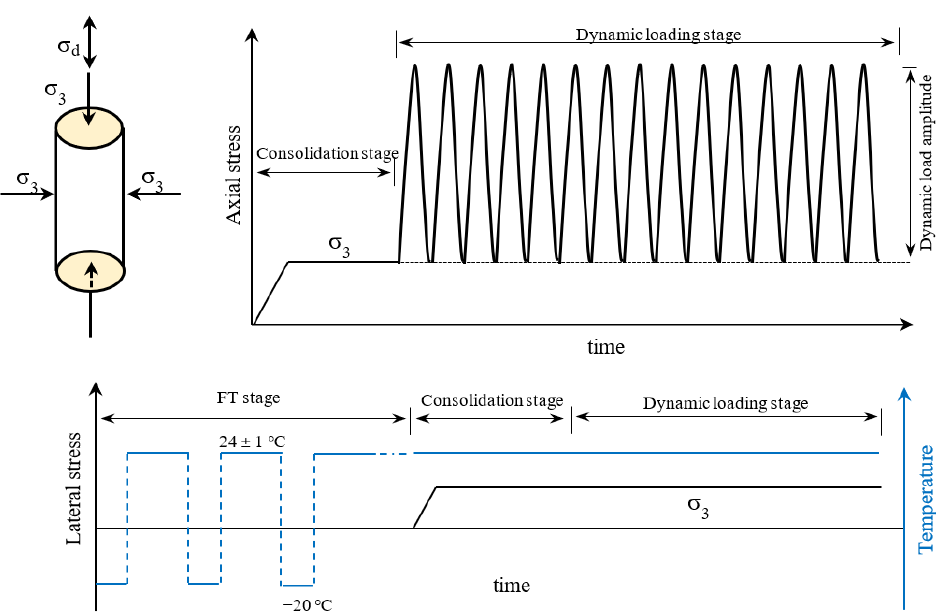
Figure 3. Loading